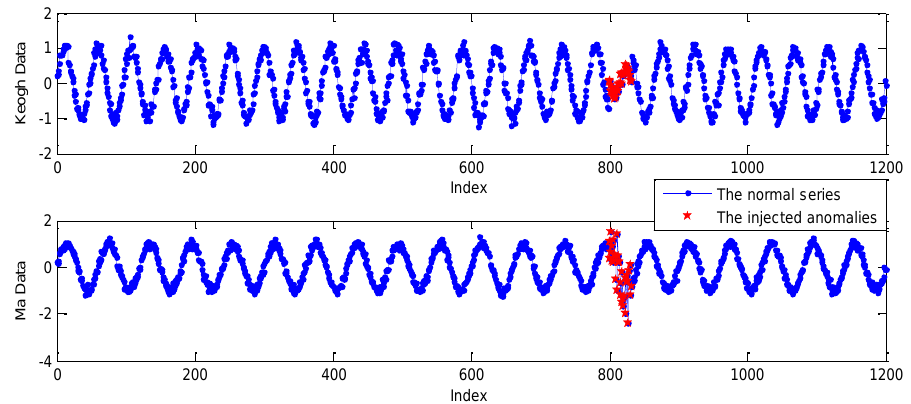
Figure 5. One example of Keogh Data and Ma